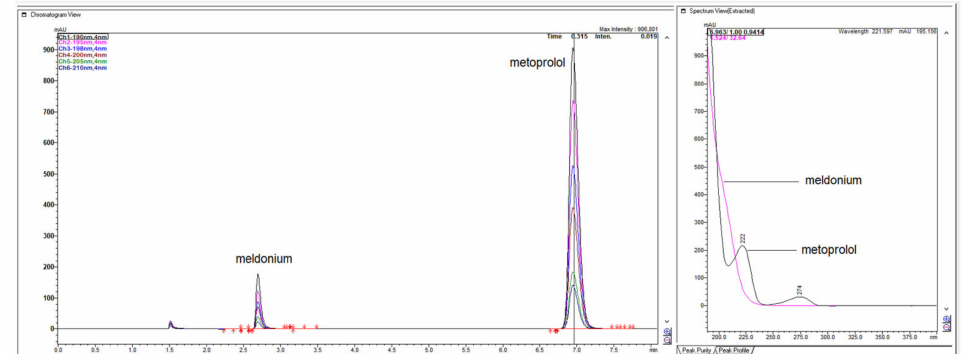
Figure 14. Chromatogram using Waters Spherisob CNRP 250 × 4.6 mm 5 µ m column with 50% ACN and 0.15% NH 4 H 2 PO 4 in 50:50 ratio.